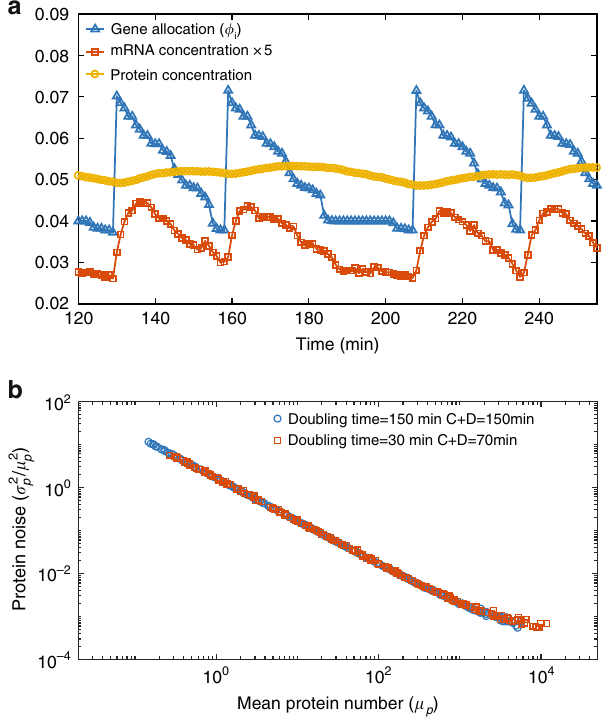
Fig. 3 Effects of fi nite duration of DNA replication. a The time trajectory of gene allocation fraction (triangles), mRNA concentration (squares) and protein concentration (circles) of a high copy number protein ( μ p ≈ 10 4 , see ( b )). The doubling time is T = 30 min, and we use the values of the C and D periods from ref. 57 , namely, C = 35 min and D = 35 min. In this situation, the cell undergoes DNA replication throughout the cell cycle. Nevertheless, the noise in ϕ i does not propagate to the noise in protein concentration signi fi cantly. The value of mRNA concentration is 5 times ampli fi ed for clarity. b An exponentially growing population is simulated (See Methods). The noise magnitude is quanti fi ed as the square of CV of protein concentrations. The mean protein number ( μ p ) is the protein number per average cell volume. Gene dosage effects due to DNA replication do not generate a signi fi cant global extrinsic noise. Two different doubling